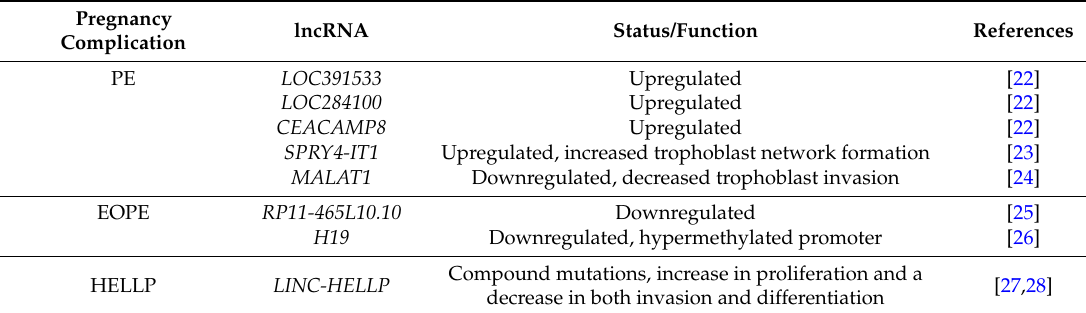
Table 1. Summary of long non-coding RNAs (lncRNAs) linked to pregnancy complications and their